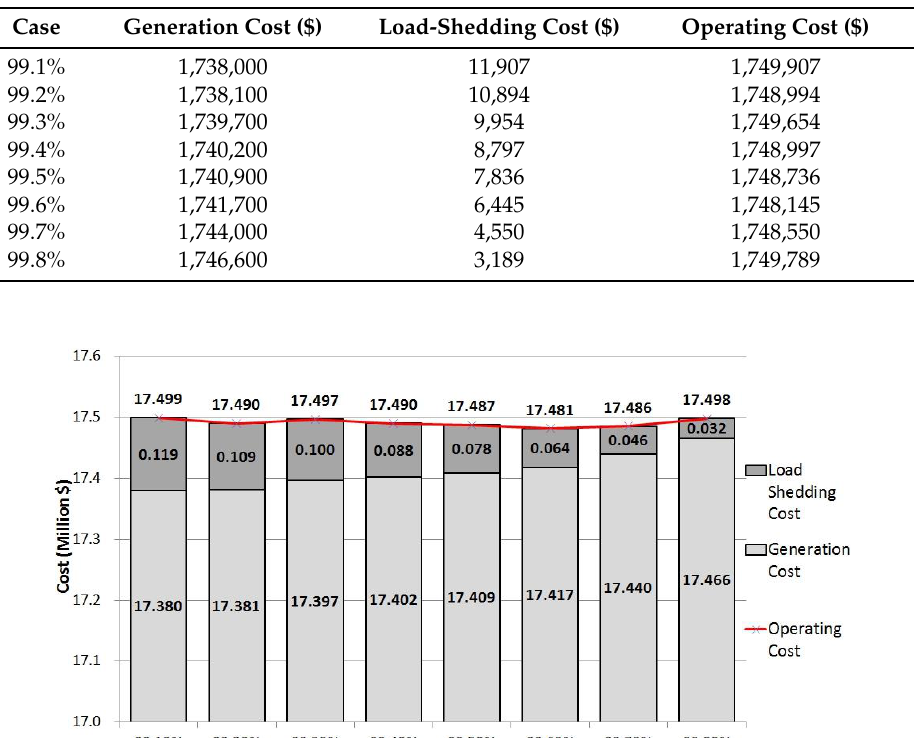
Figure 5. Hourly reserve margins for the conventional method (a fixed reserve margin of 292 MW) and the proposed method (based on a short-term reliability of balance of 99.6%). Table 3 lists the average, maximum, and minimum reserve margin for 24 h using the data shown in Figure 6. Because of uncertainties in the forecast demand, the outages of generators and wind power error vary from hour to hour; the times for the maximum and minimum reserve margin depend on the combination of these three uncertain factors.